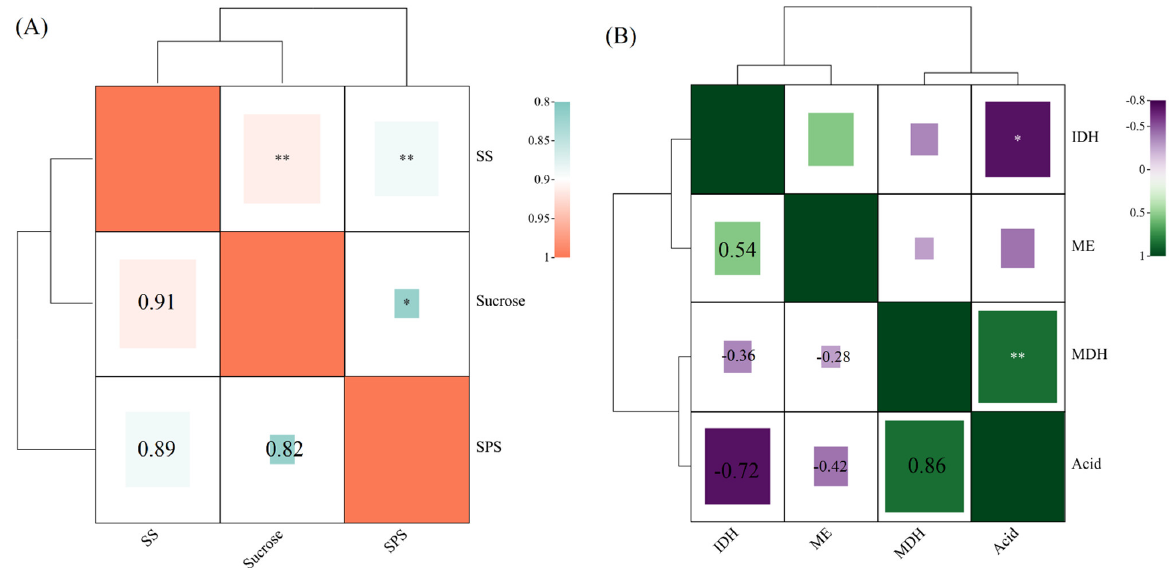
Figure 4. Correlation analysis of sucrose and acid content and related enzyme activities. ( A ) Corre- lation analysis between sucrose content and sucrose-related enzyme activity. ( B ) Correlation analy- sis between acid content and acid-related enzyme activity. * At the level of 0.05, the correlation shows significance. ** At the level of 0.01, the correlation shows high significance.